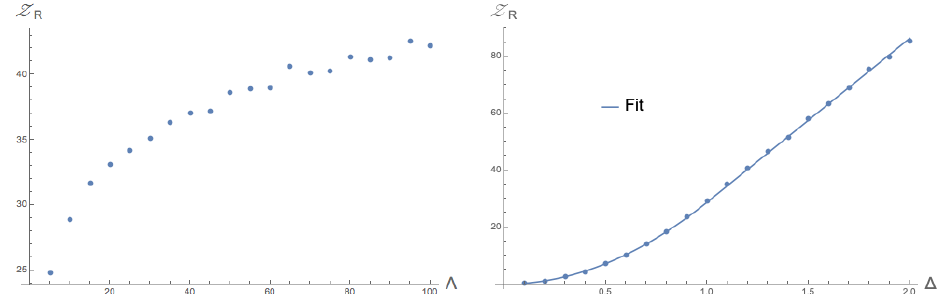
Figure 7. Numerical evaluation of Z R = 2 ( ∆ ) for N = 2. On the left , we set ∆ = 1 and vary Λ on the horizontal axis. It can be seen that the value indeed diverges linearly, as is expected from the discussion in Section 4, since this corresponds to a divergence of G R ( (cid:101) ) ∝ (cid:101) − 1/2 because of (cid:101) ∼ Λ − 2 . On the right , we set Λ = 10 and vary ∆ on the horizontal axis to show that the functional form (except for the divergent part) is still given by the Formula